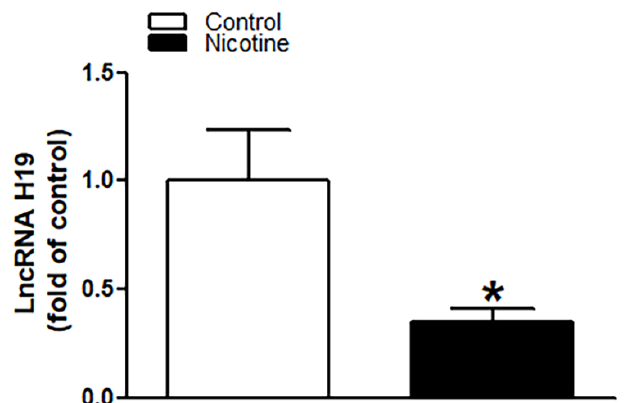
Figure 5. Perinatal nicotine exposure significantly attenuated the expression levels of lncRNA H19 in neonatal brain. Brains were isolated from 9-day-old neonatal rat pups in both saline control and nicotine exposed groups. qRT-PCR analysis was employed to evaluate the level of lncRNA H19 in the brain. As presented, expression levels of lncRNA H19 significantly decreased in nicotine exposed animals as compared to the saline controls. Data are means ± SEM. * p < 0.05 , control vs. nicotine. n = 5 animals/group.